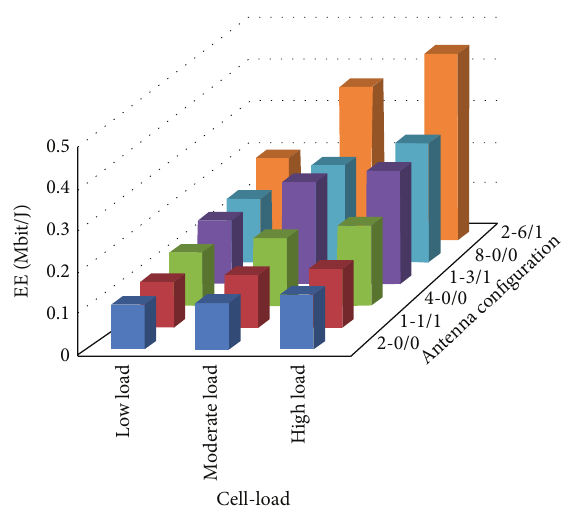
Figure 5: Comparison of cell throughput in three different cell-load scenarios and antenna configurations. 𝐵 𝑤 = 1.4 MHz.